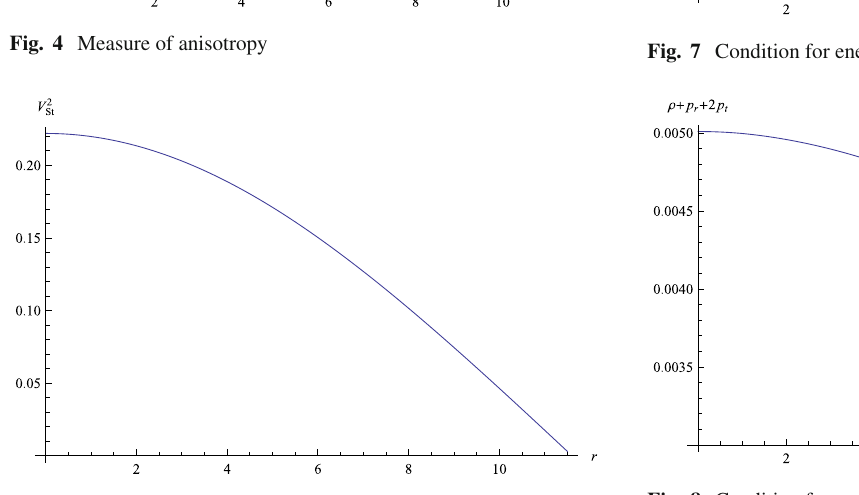
Fig. 8 Condition for energy–momentum tensor